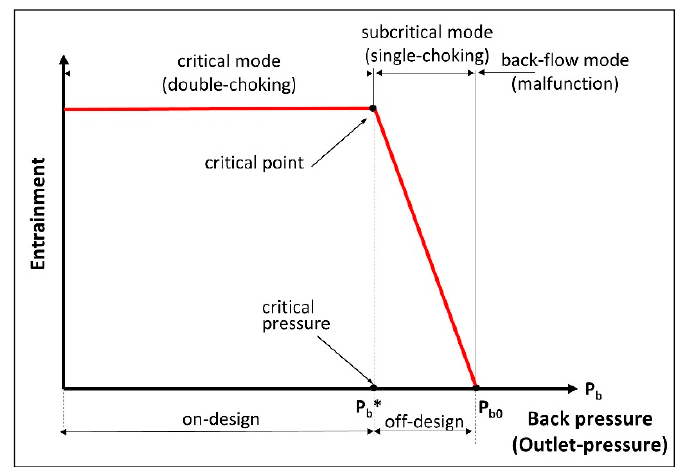
Figure 10. Ejector characteristic curve with operation zones.